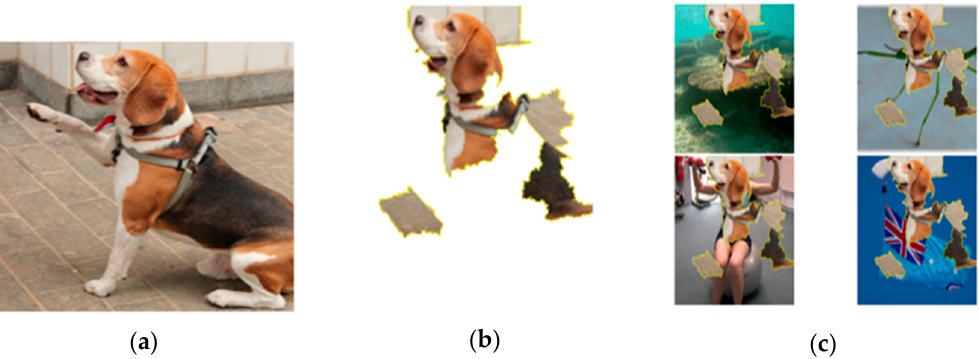
Figure 1. Relationships between the values of features and specific types of attacks. ( a ) Original data; ( b ) Key elements needed for explanation among data; ( c ) Examples of explanations through only key elements.